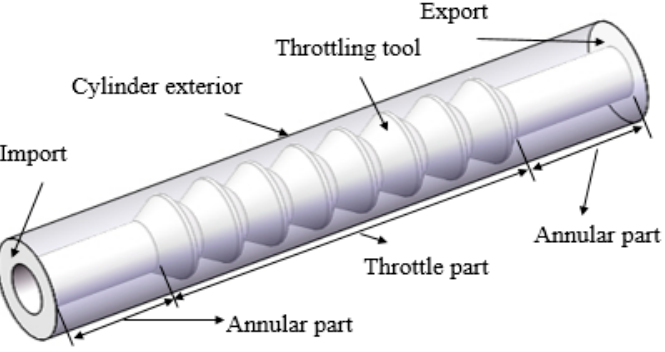
Figure 1. Three ‐ dimensional representation of the partial pressure tool model.